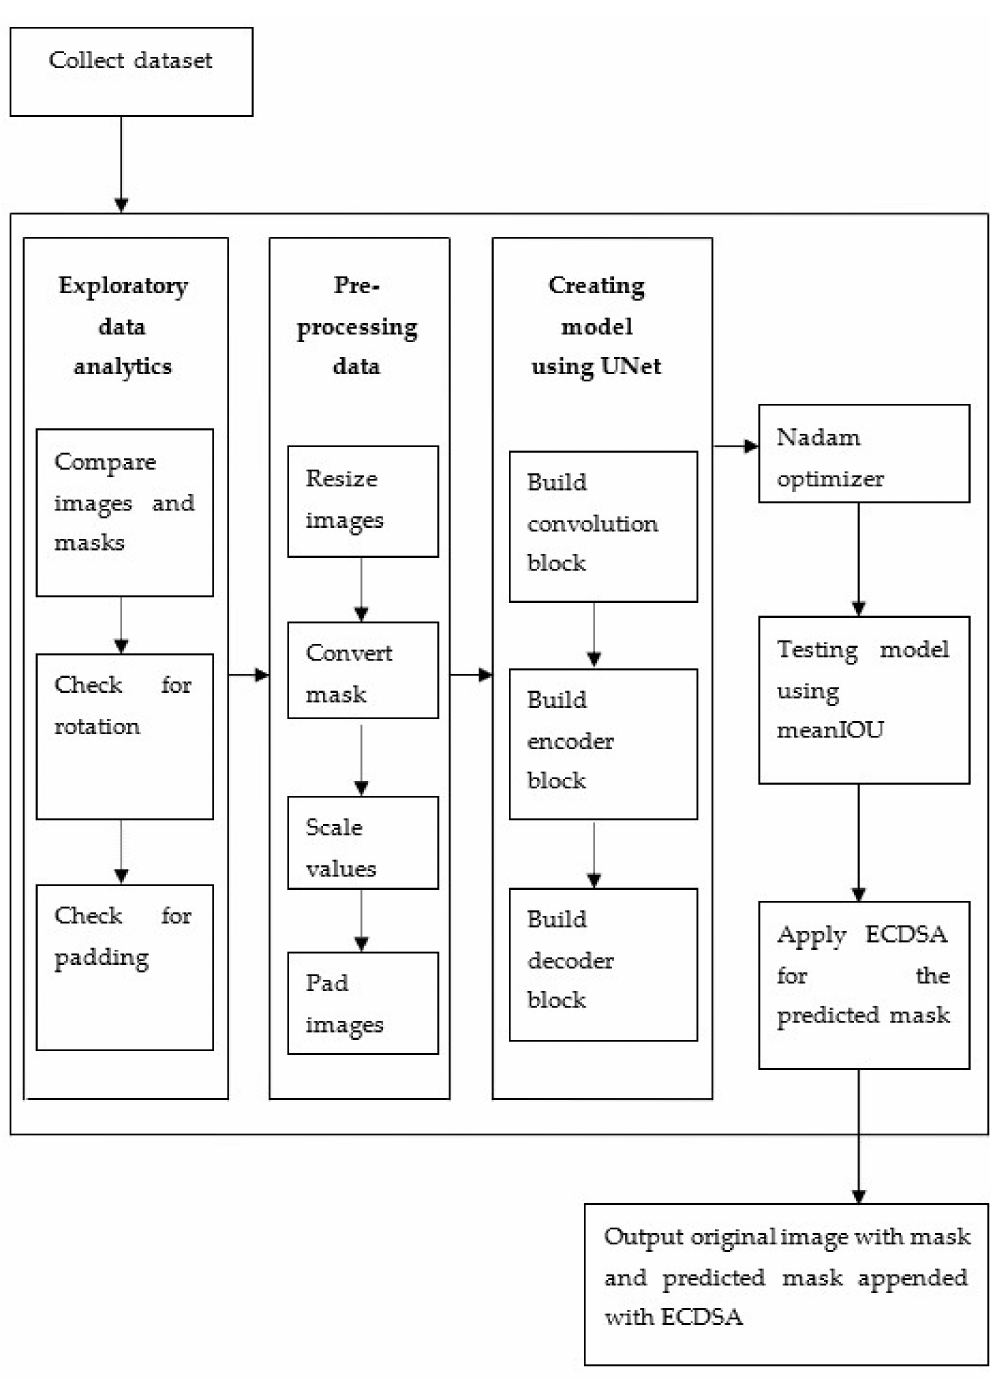
Figure 2. Proposed